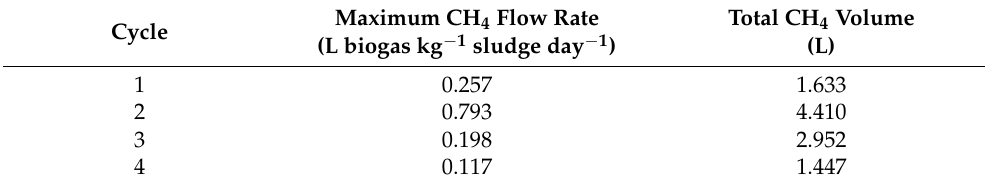
Table 5. Biogas production during activated sludge digestion.